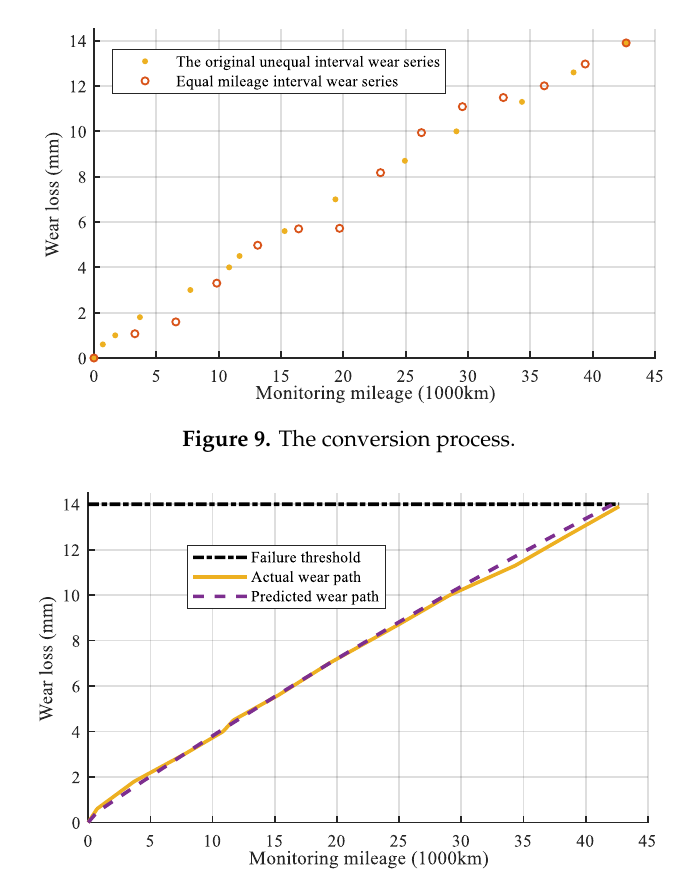
Figure 10. The actual wear path and predicted wear path of sample 1.